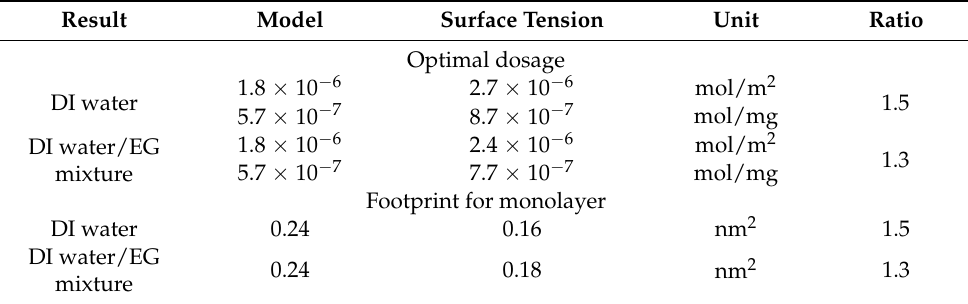
Table 2. Summary of geometric adsorption model results.